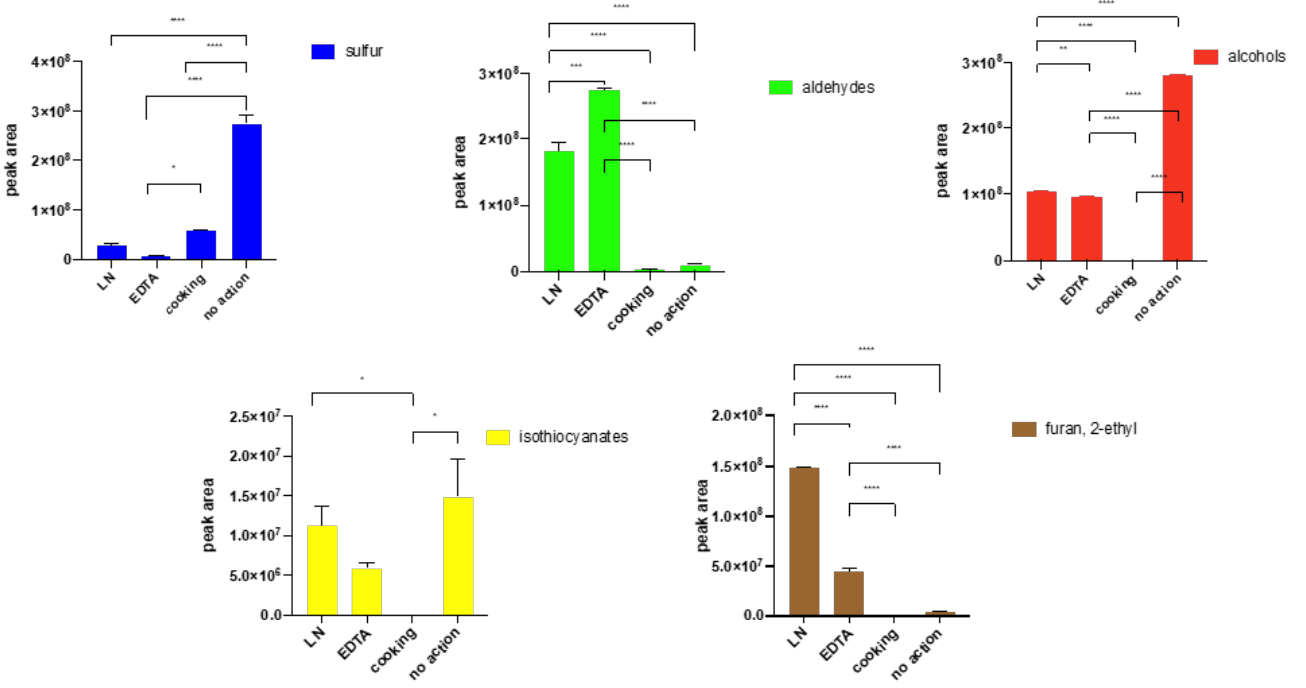
Figure 6. Influence of enzymatic reactions quenching in broccoli florets on extracted volatiles. Each bar graph is expressed as mean value ± standard deviation. * p ≤ 0.05, ** p ≤ 0.01, *** p ≤ 0.001, **** p ≤ 0.0001 (according to the ANOVA test—Turkey’s test).